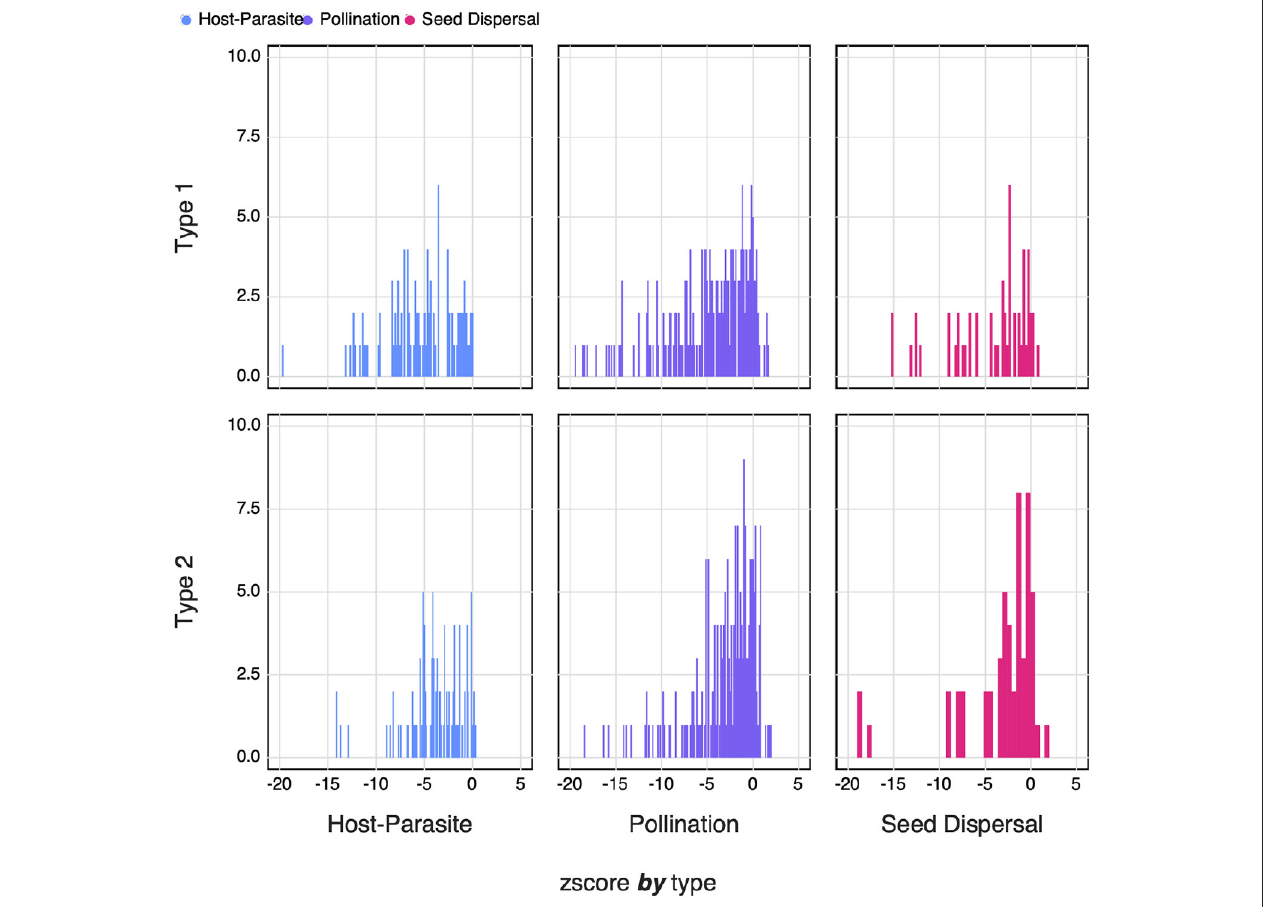
FIGURE 7 | The counts of the z i -scores of different types of networks for both Type I and Type II null models. Negative z i -scores indicate networks with an SVD entropy that is lower i.e., less complex than